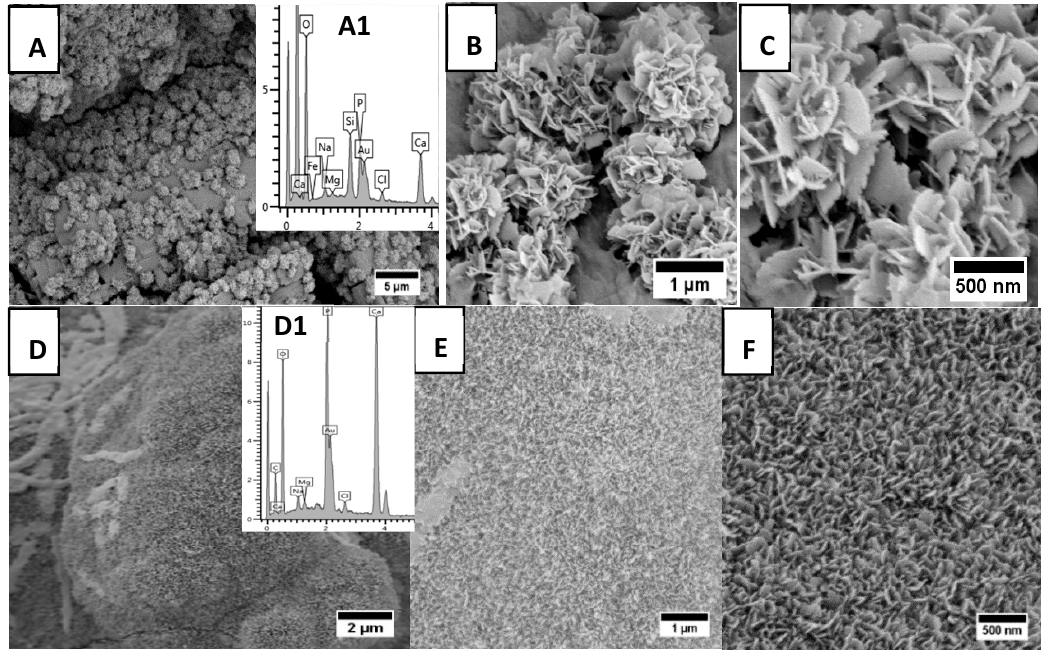
Figure 12. SEM images of the surface of the multilayer coating after treatment in SBF at di ff erent magnifications after 7 days [( A – C ), corresponding EDX spectra ( A1 )] and after 14 days [( D – F ) and corresponding EDX spectra ( D1